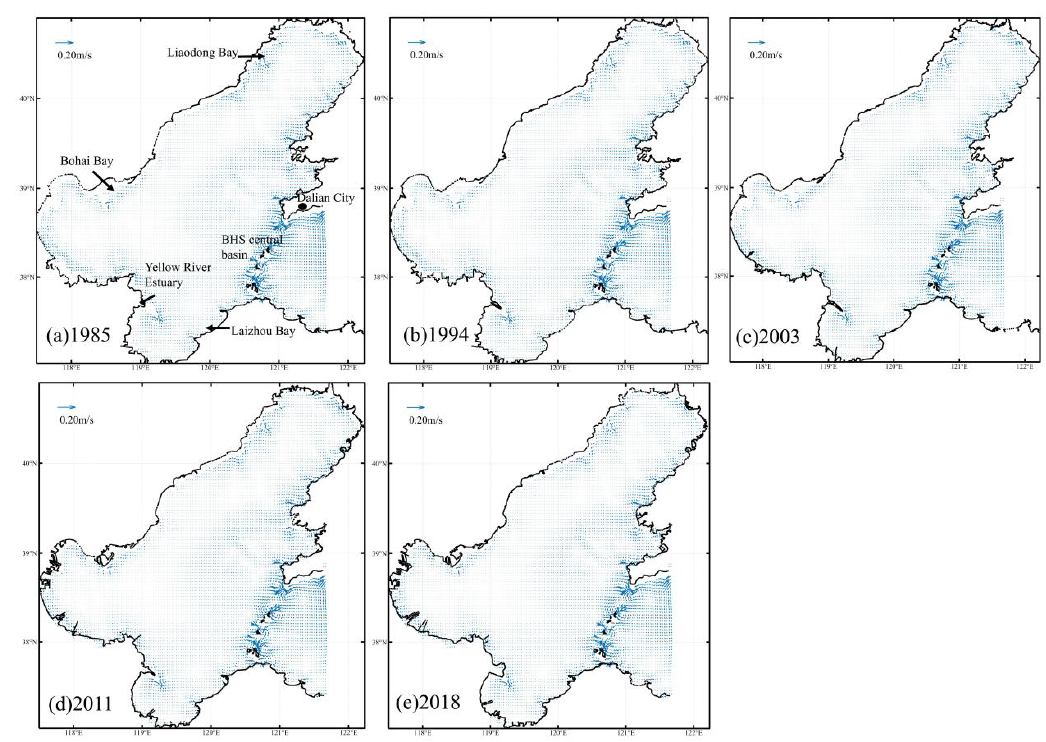
Figure 11. RC map for the five years. Arrows denote the speeds, and their lengths were determined by the magnitude of the residual velocity.